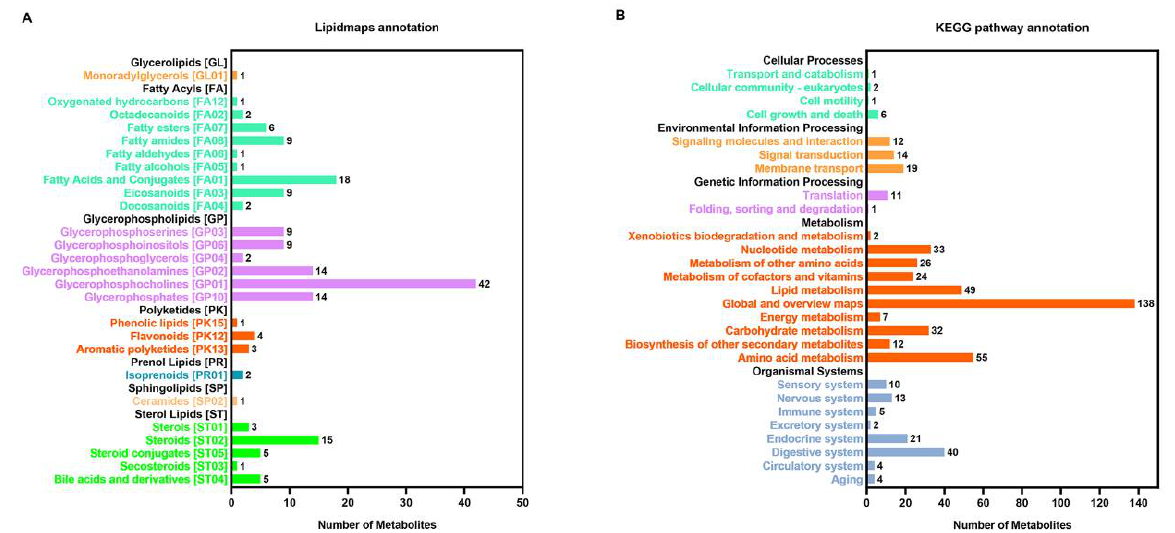
Figure 2. Annotation of metabolites of C. farreri under heat stress by Lipidmaps ( A ) and KEGG pathways ( B ). The X -axis represents the number of metabolites. The Y -axis represents the annotated Lipidmaps or KEGG terms.